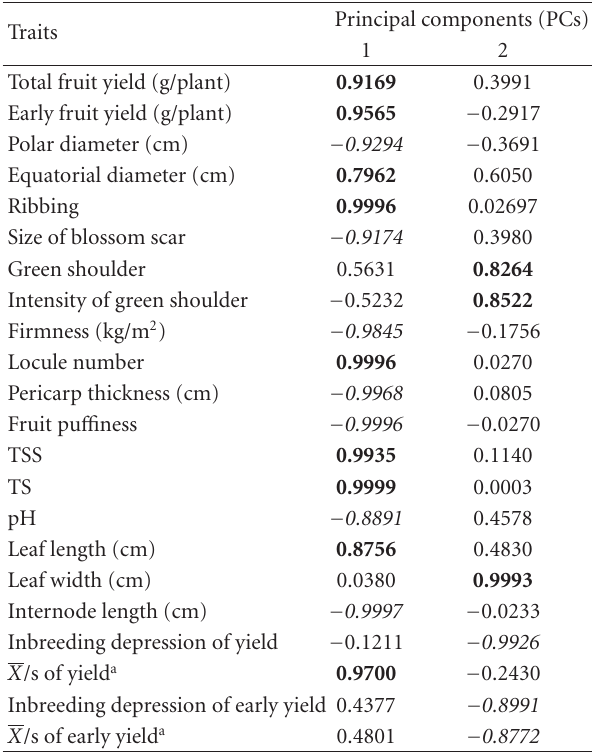
Table 5: Loadings of the traits onto two principal components for